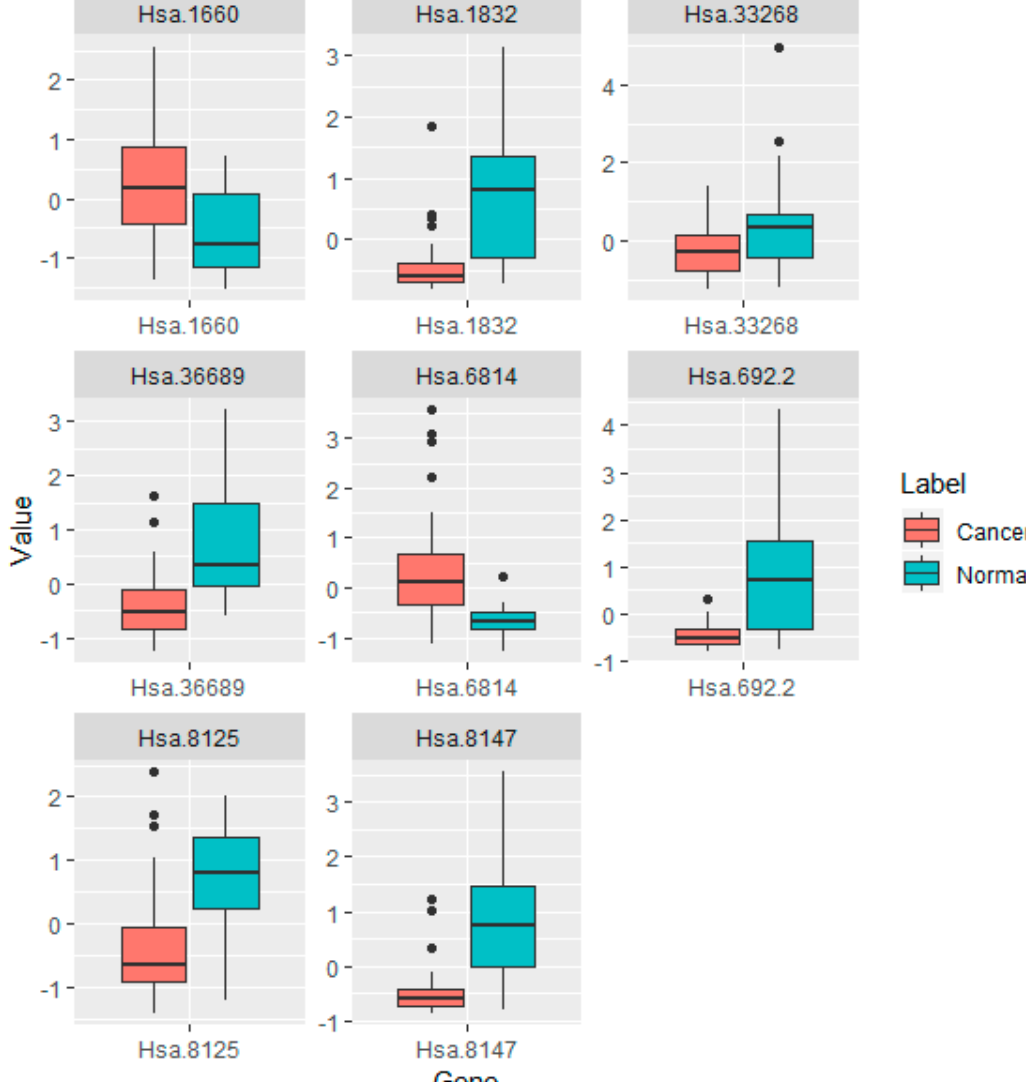
Figure 5. Boxplots of differential expression level between normal and colon samples on eight genes from SIS-LASSO, SIS-MCP, and SIS-SCAD with the ranked data. Each boxplot contains the p-value of mean differential expression between two groups with a two-sample t-test.